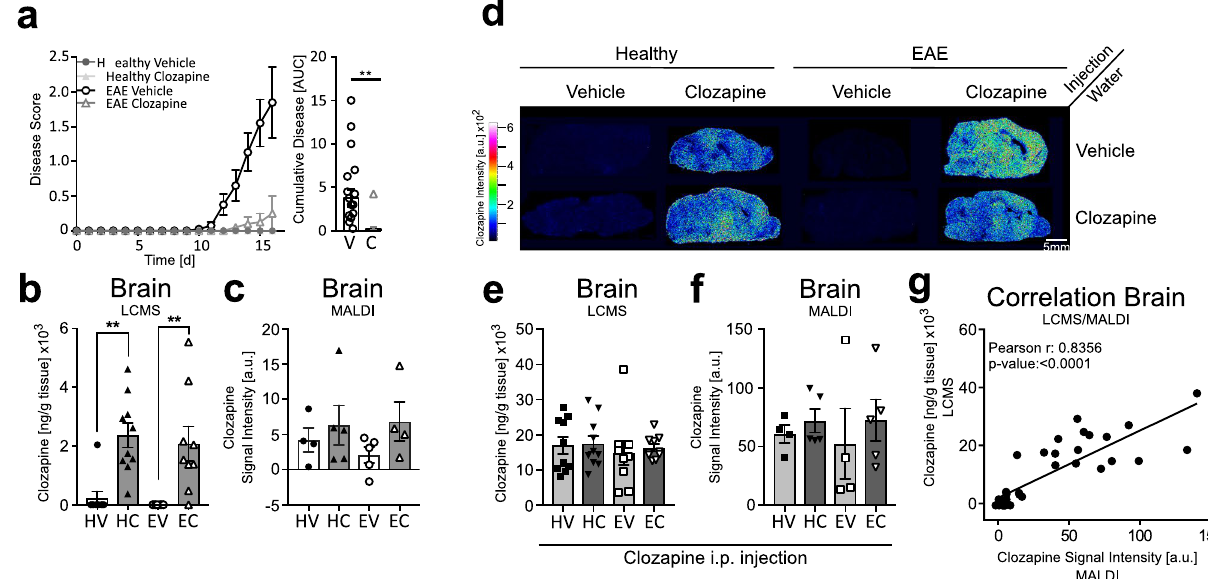
Figure 1. Clozapine in the brain of healthy and EAE mice. Mice were treated with clozapine or vehicle 1 day prior to EAE induction in the drinking water and scored daily (0: normal to 5: moribund). 30 min before euthanasia mice were injected i.p. with 10 mg/kg clozapine (a) Disease course of mice and disease burden assessed by area under the curve analysis. Shown are the means and SEM of individual mice from two experiments combined (n = 20 mice/group), Paired t test, two-tailed **p < 0.0021 (b,d) Absolute concentration of clozapine in mouse brain measured with LC–MS (n = 10 mice/group) one-way ANOVA repeated measure followed by Tukey Test, **p < 0.01 (c,e) Quantification of clozapine intensity by MALDI IMS in the whole mouse brain (n = 4–5 mice/group) (f) Positive correlation of absolute clozapine concentration by LC–MS and clozapine intensity by MALDI; Pearson correlation coefficient: 0.8477 with p-value < 0.0001. (g) Representative MALDI images from all eight treatment